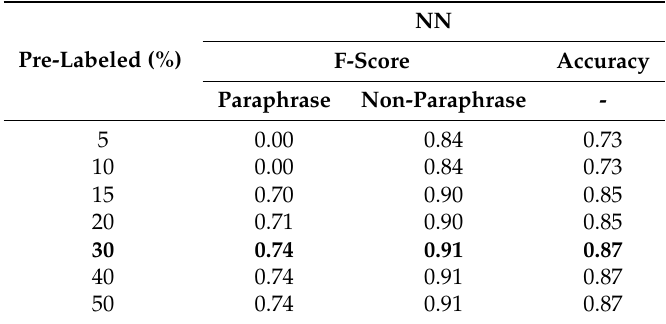
Table 7. Results of the LLGC regularizer and the NN classifier.